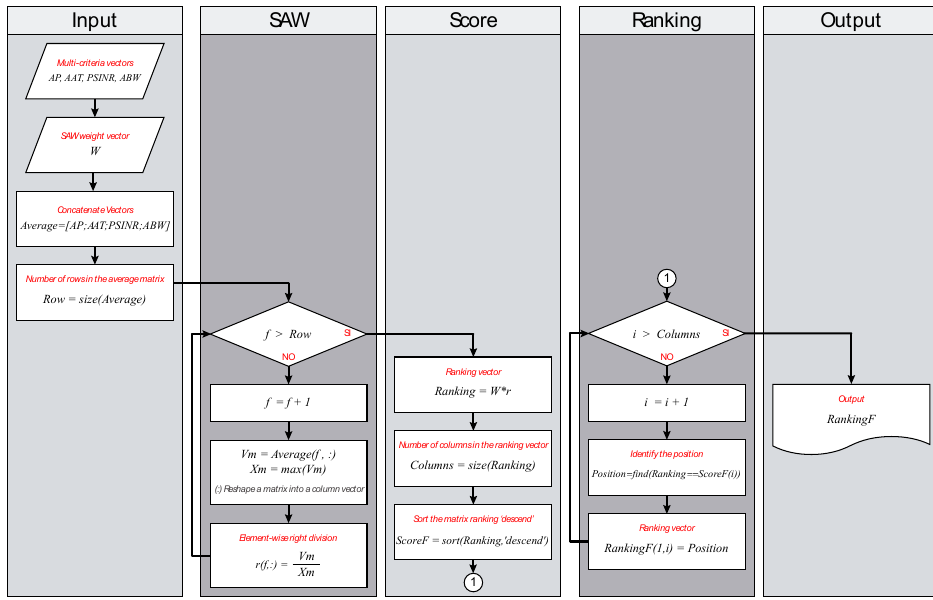
Figure 13. Simple Additive Weighting (SAW) algorithm flowchart.